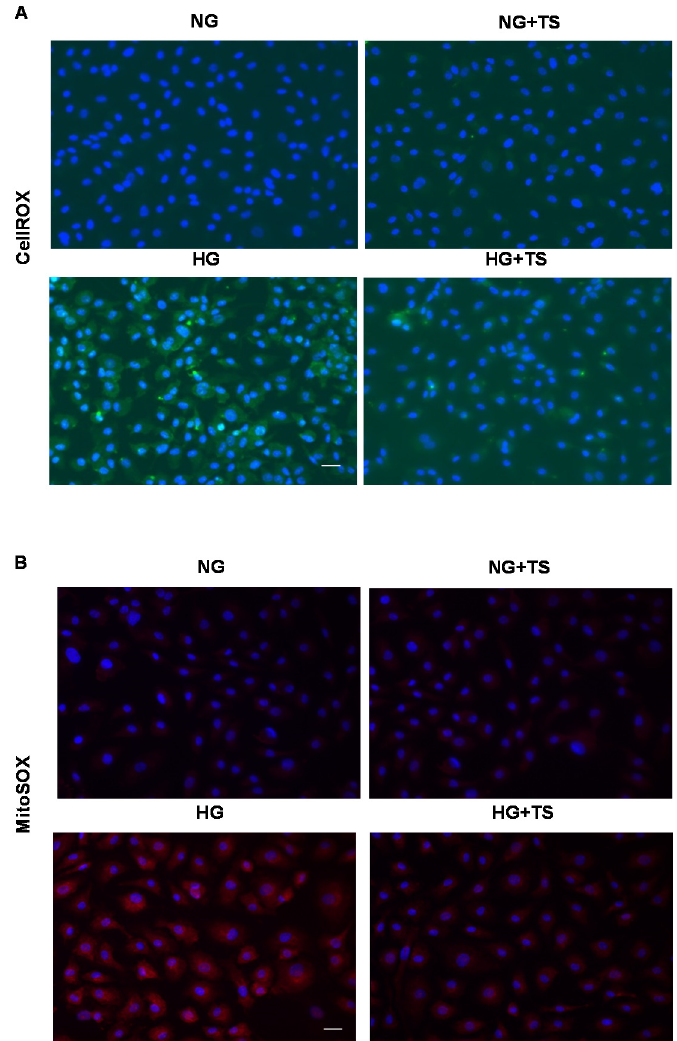
Figure8. E ff ectsofTubastatinAoncellularandmitochondrialoxidasesactivitiesinHuREC.( A )CellROX fluorescent assay showing superoxide formation (green) in HuREC exposed to HG for 48 h or to HG in the presence of 5 µ M of TS (HG + TS) and compared to HuREC cultured in NG conditions in the absence (NG) or in presence of 5 µ M TS (NG + TS). ( B ) Images of MitoSOX assay showing superoxide formation from mitochondria oxidase (red) in HuREC exposed to HG for 48 h or HG in the presence of 5 µ M of TS (HG + TS), also for 48 h, and compared to HuREC cultured in NG conditions in the absence (NG) or in the presence of 5 µ M TS (NG + TS). In A and B blue fluorescence show cell nuclei counterstained with DAPI. Scale bar, 50 µ